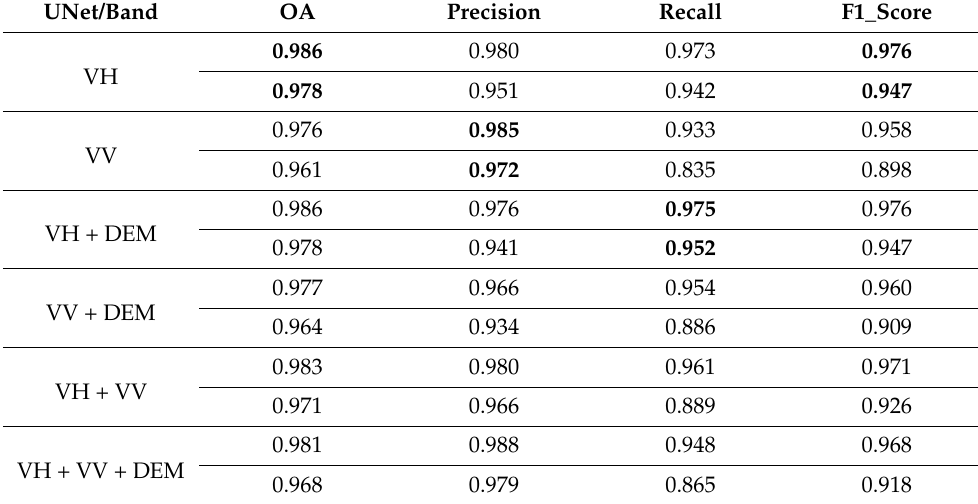
Table 4. Band comparison experiments on UNet with two di ff erent test datasets. The fi rst line pre- sents the model performances with test dataset 1, and the second with test dataset 2. The values in bold indicate the highest numbers for corresponding metrics.